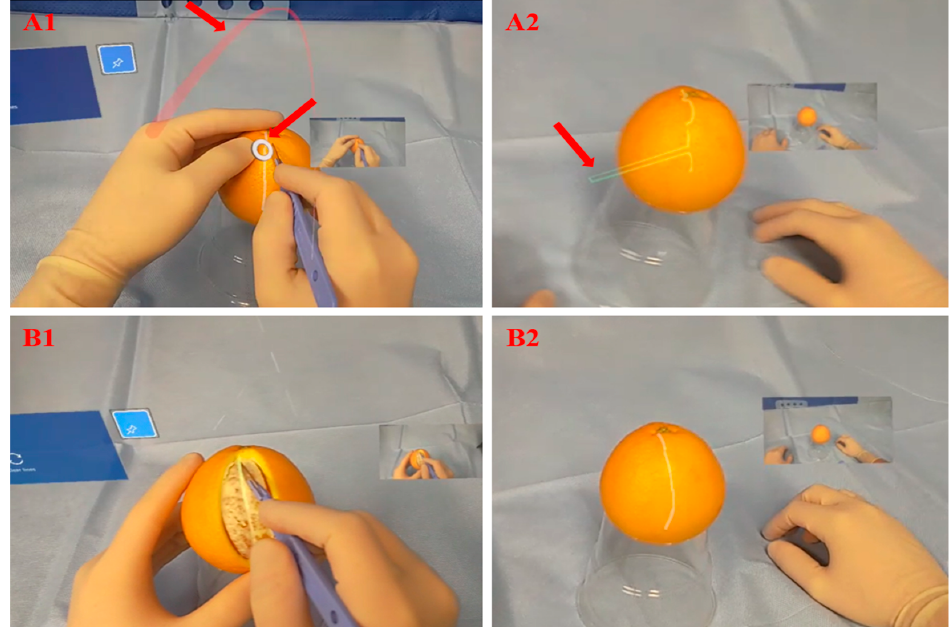
Figure 1. Images taken on the RISP during its development. ( A1,A2 ) show an early version with distracting UI (red arrows) ( A1 ) and poor depiction on the surface ( A2 ). ( B1, B2 ) show a later version where disturbing icons have been removed ( B1 ) and the surface depiction is accurate ( B2 ).